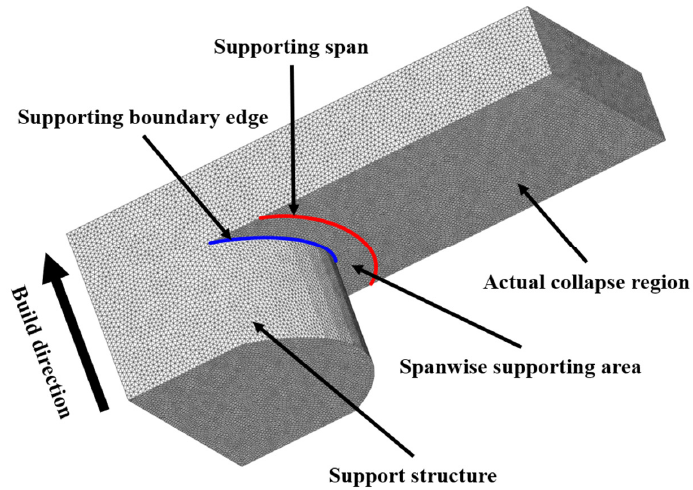
Figure 3. Overhanging structure with spanwise supporting area.